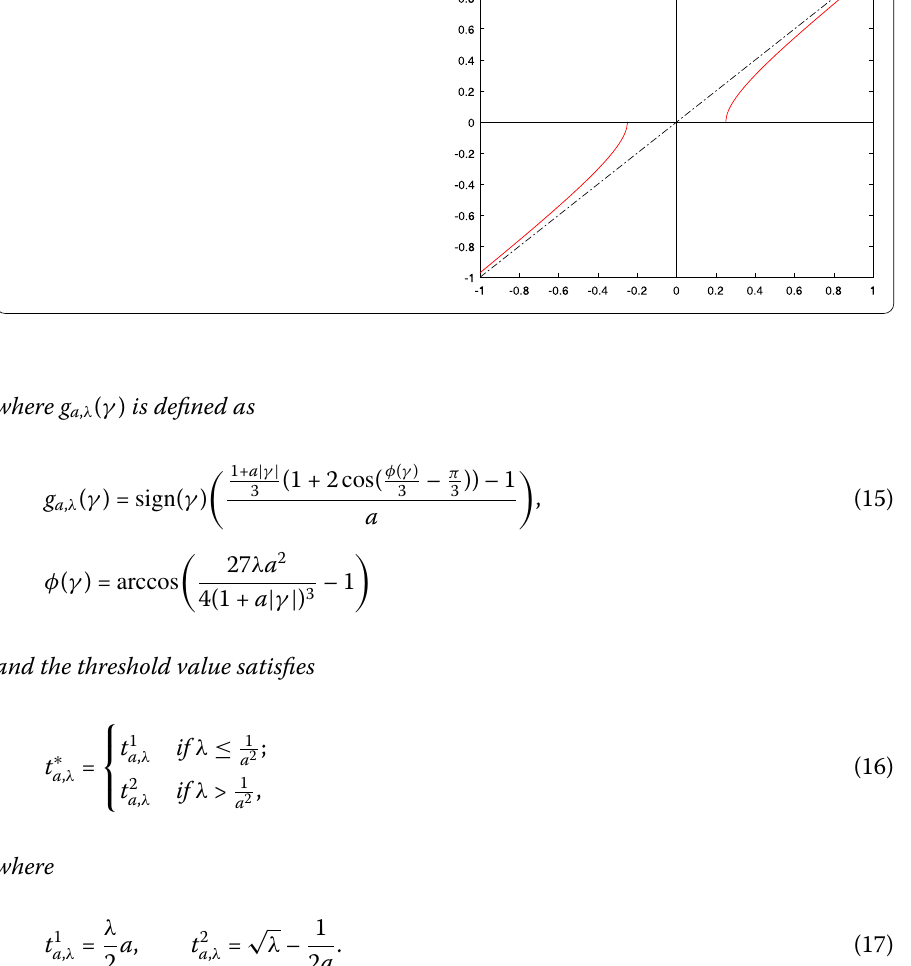
Figure 3 Plot of the threshold function g a , λ for a = 2 and λ =